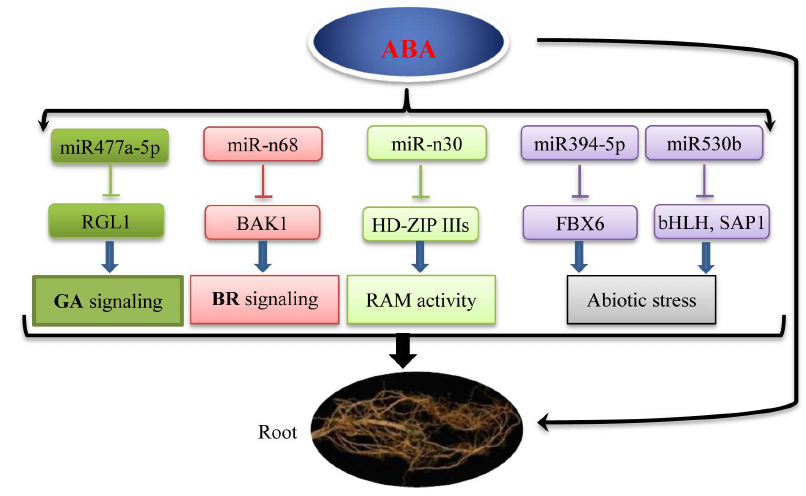
Figure 10. A new model of ABA regulation of root growth through miRNA-mediated pathways. The arrow indicates positive regulation. The inverted “T” denotes the interactions among miRNA-target genes predicted and investigated in this study; the “arrows” mean “involved in”. RGL1: repressor of GA1-like (Potri.012G093900); BAK1: BRASSINOSTEROID INSENSITIVE 1-ASSOCIATED RECEPTOR KINASE 1-RELATED (Potri.009G090700.1); HD-ZIP III: Class III Homeodomain Leucine Zipper (Potri.004G211300); FBX: F-box protein (Potri.001G057100); bHLH: basic helix-loop-helix protein (Potri.014G099700); SAP1: A20/AN1 zinc-finger containing stress-associated protein 1 (Potri.010G076700).